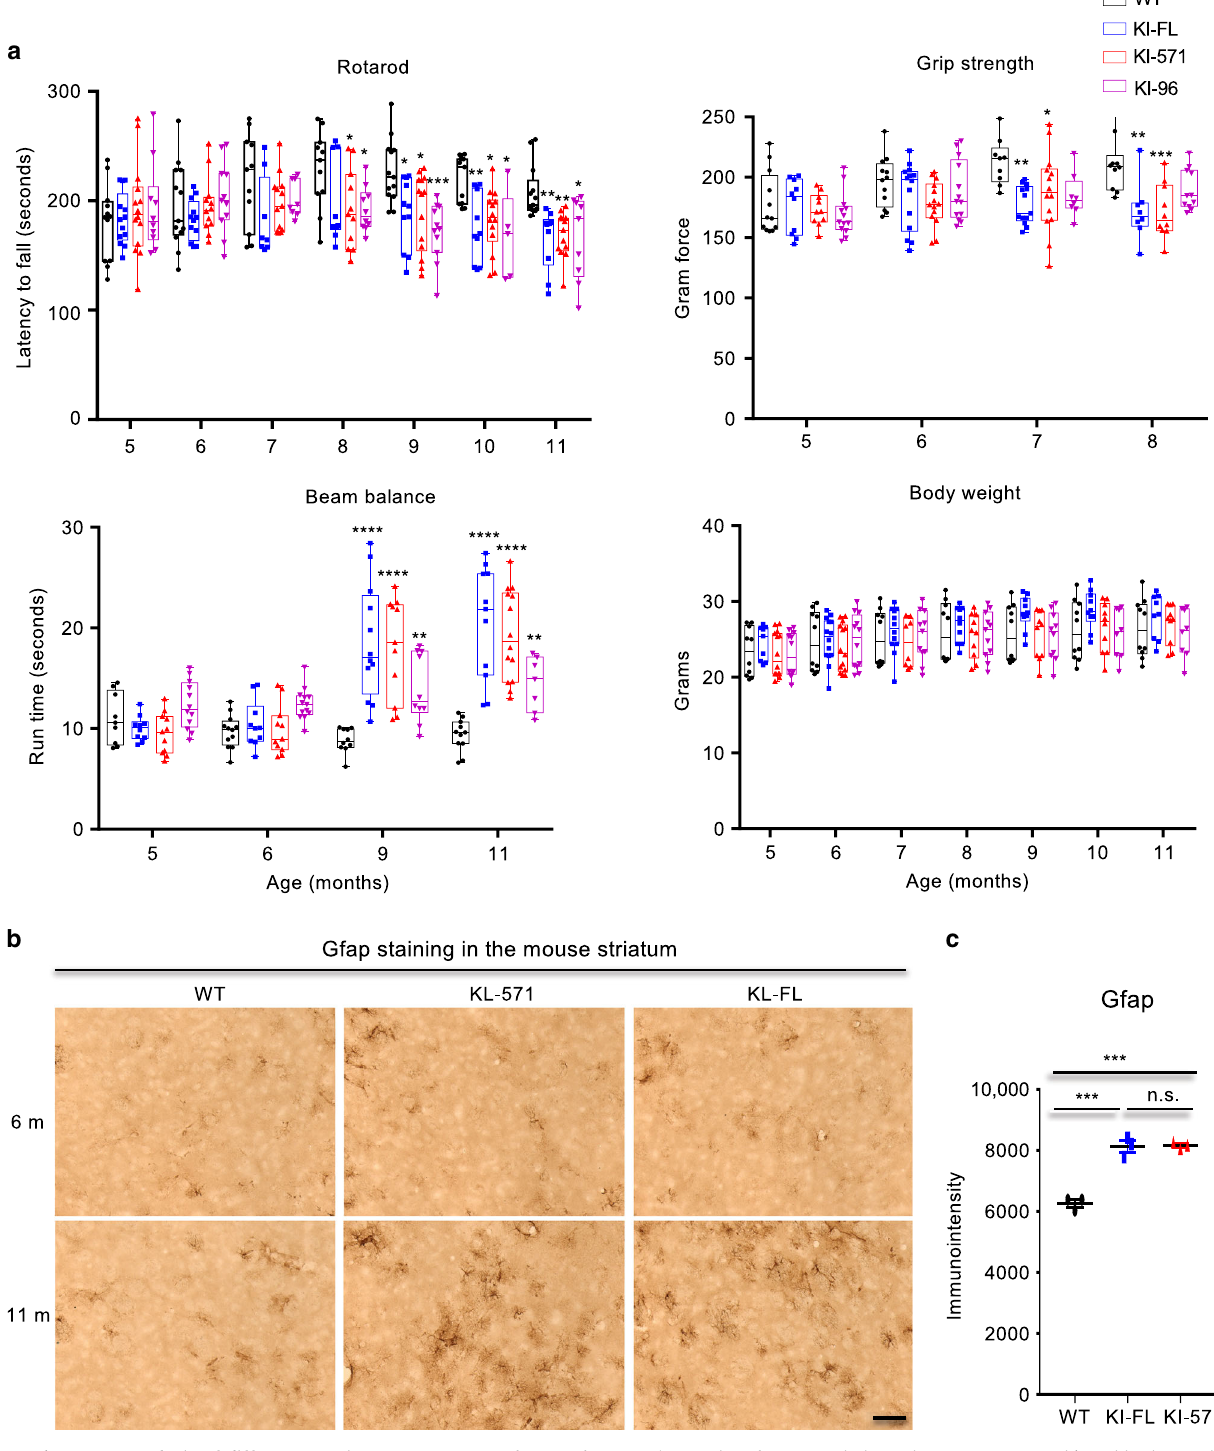
Fig. 6 Phenotype analysis of different KI mice. a Comparison of motor function (rotarod performance, balance beam, grip strength) and body weight of wild type and different types of KI (KI-96, KI-571, and KI-FL) mice. Each group consists of 14 mice. Data are presented as minimum to maximum showing all points. *p < 0.05, ** p < 0.01, *** p < 0.001, **** p < 0.0001, two-way ANOVA followed by Tukey ’ s multiple comparison tests, rotarod analysis, F = 13.73, p < 0.0001; grip strength analysis, F = 9.187, p < 0.0001; balance beam analysis, F = 20.45, p < 0.001; body weight analysis, F = 4.777, p = 0.0029. Data are presented as mean values ± SEM. b Gfap immunostaining of wild type (WT) and KI-571, KI-FL mouse striatum at 6 and 11 months of age. Scale bar: 20 μ m. c Quanti fi cation of relative Gfap immunostaining signals in wild type (WT) and KI-571, KI-FL mouse striatum. The data were obtained from six images in the striatum per mouse ( n = 3 mice per genotype, *** p < 0.001, one-way ANOVA followed by Tukey ’ s multiple comparison tests, F = 65.67, p < 0.0001). Data are presented as mean values ± SEM. Source data are provided as a Source Data fi